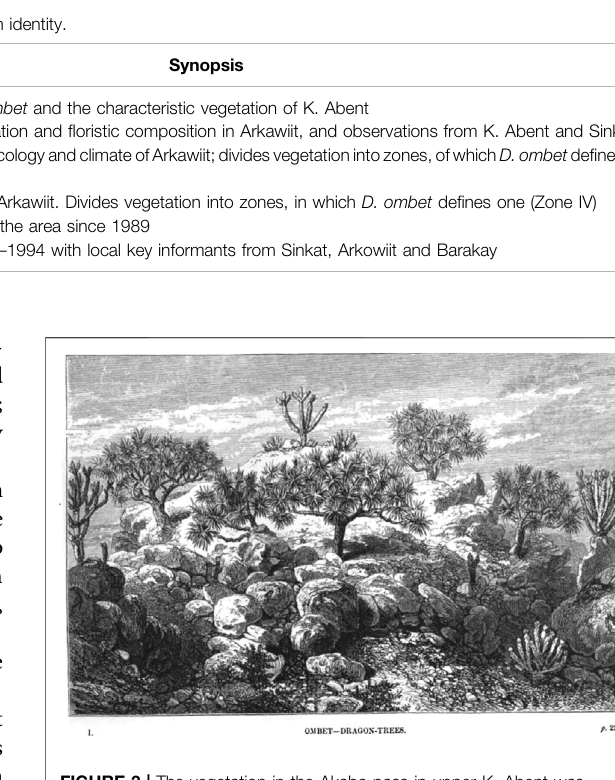
FIGURE 3 | The vegetation in the Akaba pass in upper K. Abent was illustrated by Schweinfurth in 1868. Well grown D. ombet trees are seen together with other typical species of this vegetation belt, such as Euphorbia abyssinica and Caralluma acutangula (lower right corner, according